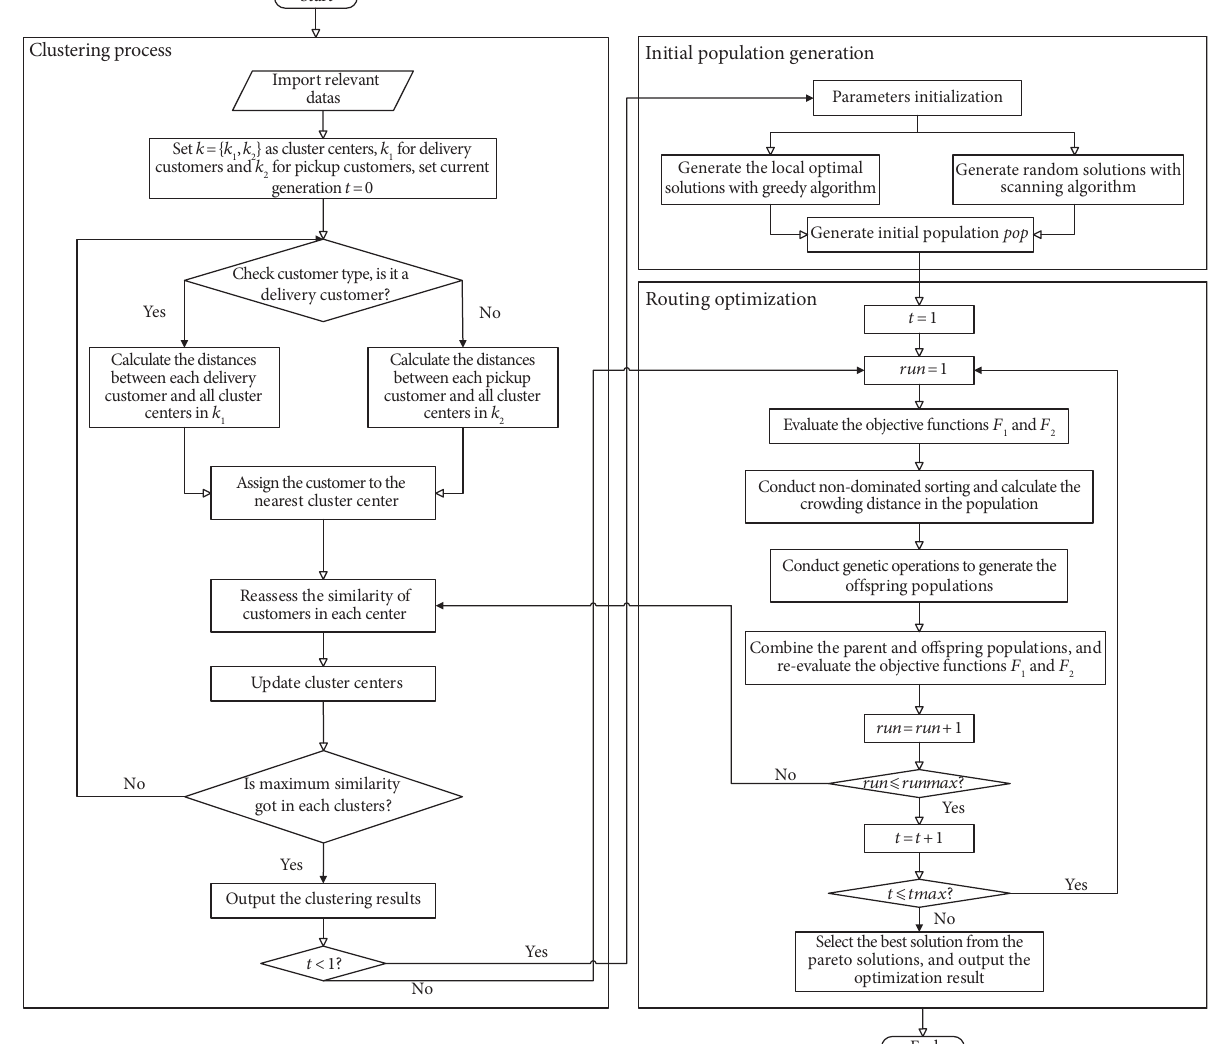
Figure 2: Flowchart of the hybrid heuristic algorithm.